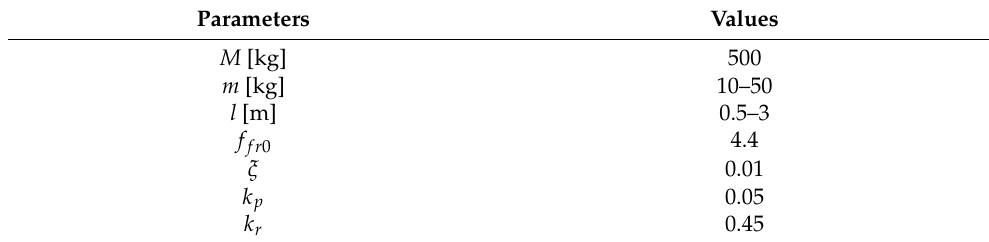
Table 1. Simulation model parameters.